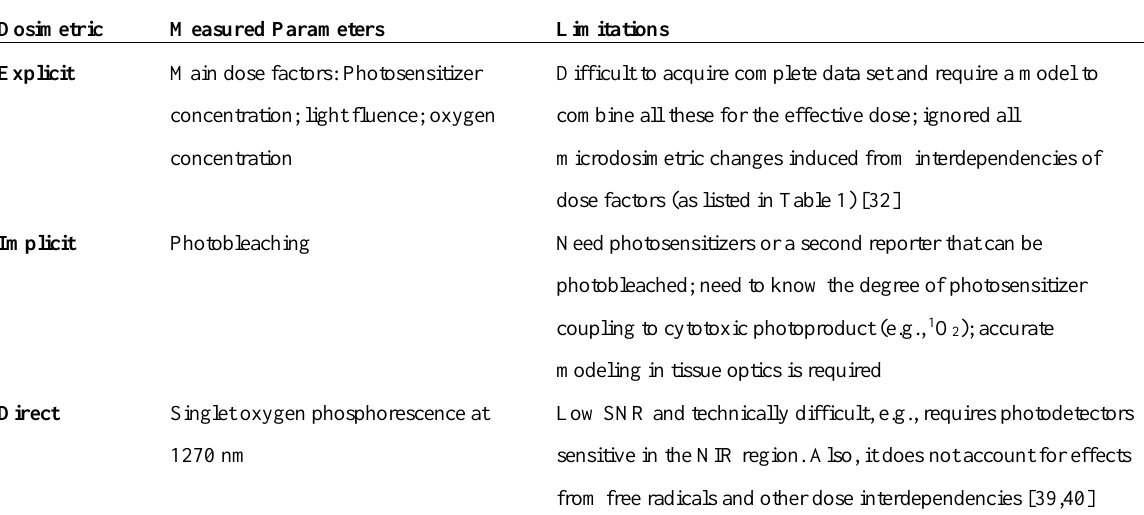
Table 2. Dosimetrics of